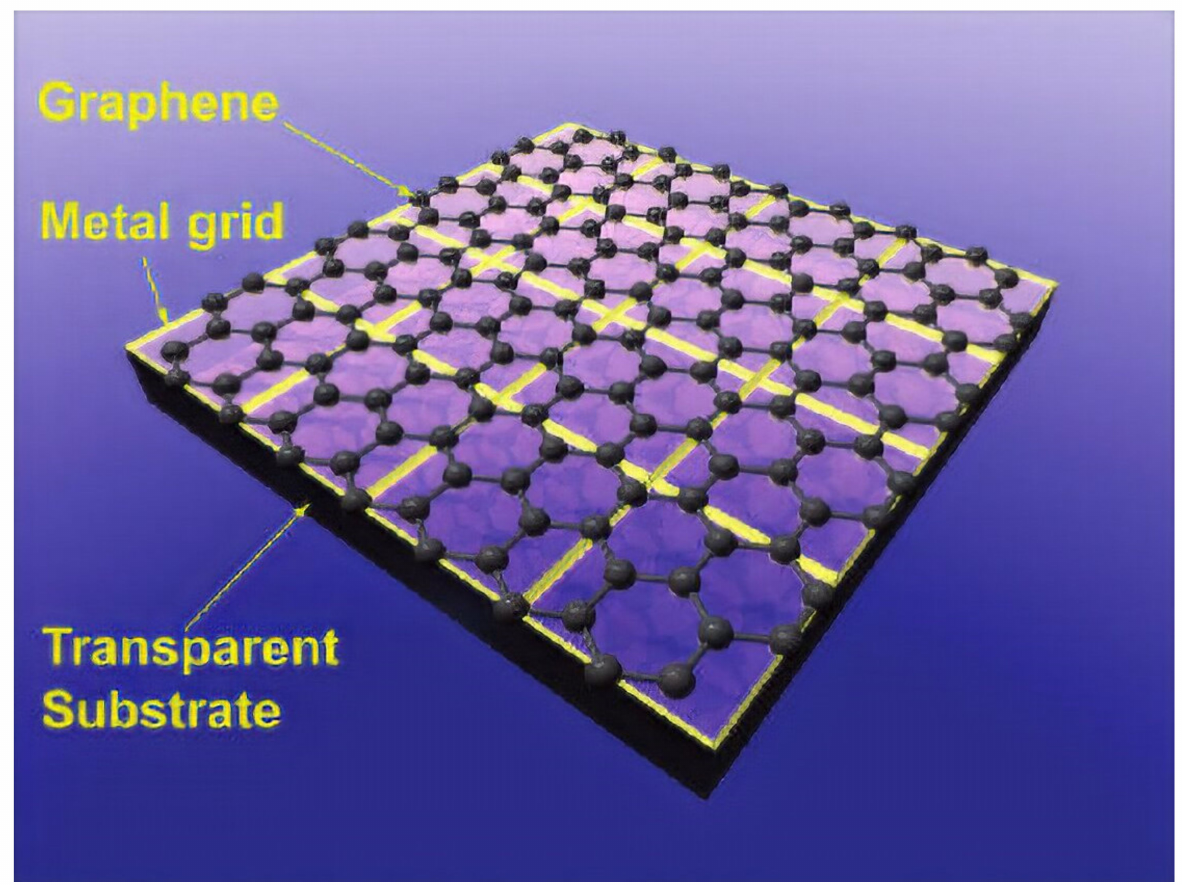
Figure 8. Metal grid/graphene hybrid transparent electrode. The yellow lines in the figure represent the metal grid. The grid size and grid-line width in the figure are only illustrative and are not scaled with the graphene molecular structure. (Reproduced with permission from ref